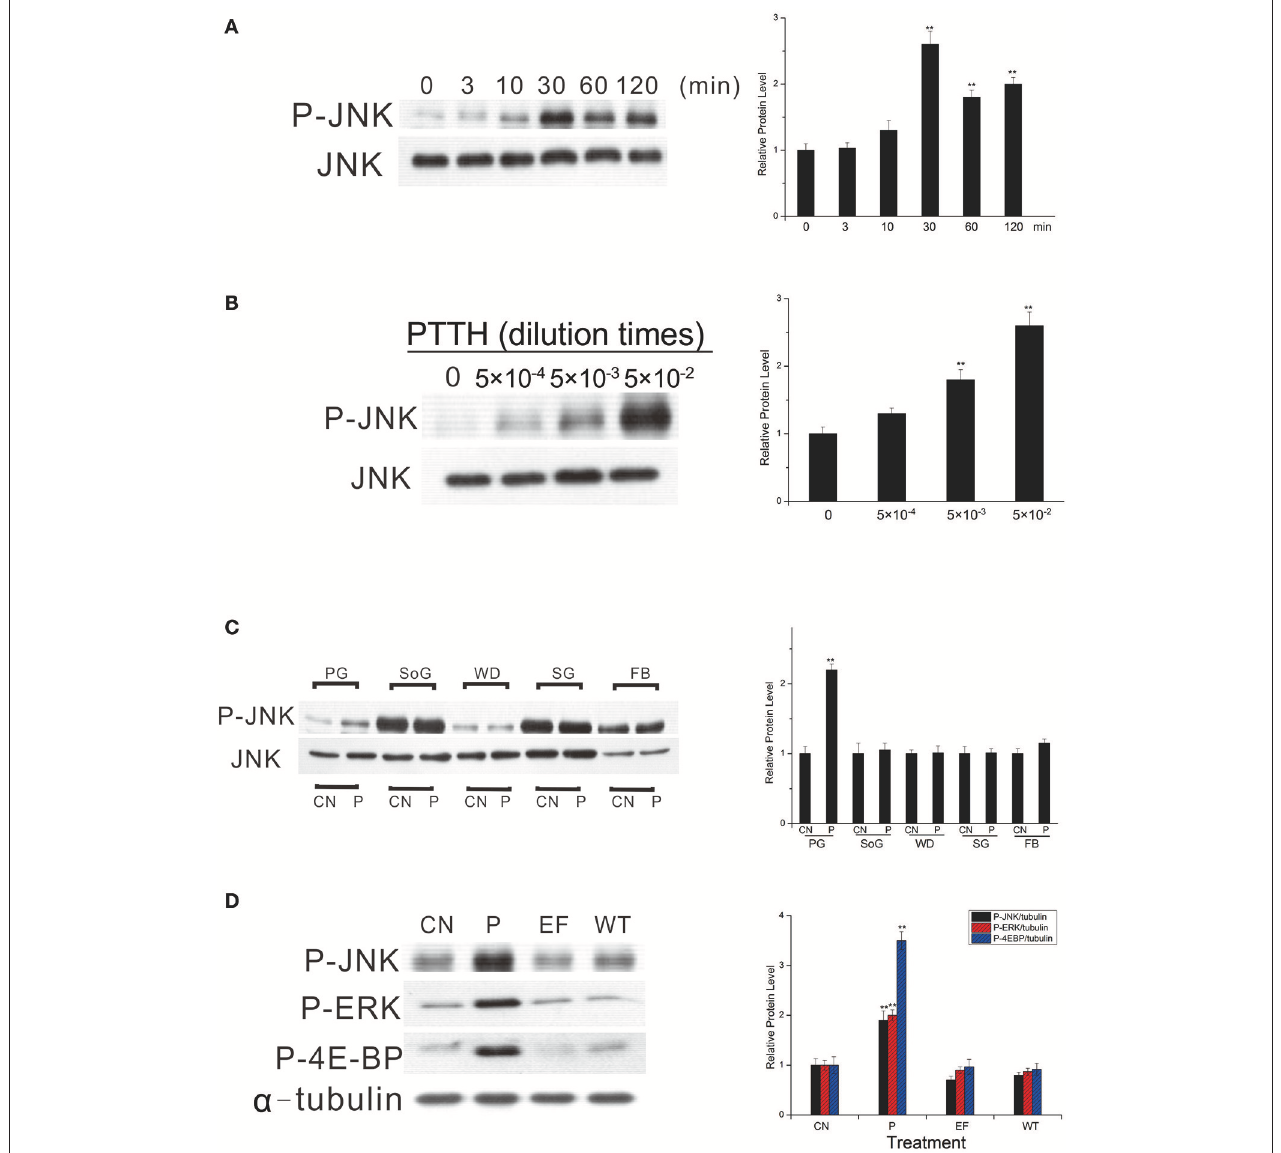
FIGURE 2 | Time- (A) and dose- (B) dependent effects of JNK phosphorylation by the PTTH, tissue specificity of PTTH-stimulated JNK phosphorylation (C) , and the effect of treatment with extracellular fluid from cells only or cells infected with the wild-type (WT) AcMNPV on protein phosphorylation (D) . (A,B) Time- and dose-dependent effects. PGs were either treated with PTTH for the indicated time points (A) , treated with the indicated concentrations of PTTH, or incubated with control medium (0) for 60min (B) . (C) Tissue specificity. PGs, subesophageal ganglia (SoG), wing disks (WD), salivary glands (SG), and fat body (FB) from day 6-last instar larvae were incubated with control medium (CN) or medium containing the PTTH (P) for 60min. (D) Effect of treatment with either control medium (CN), the PTTH (P), extracellular fluid from cells only (EF), or cells infected with WT AcMNPV (WT) on the phosphorylation of JNK, ERK, and 4E-BP. Each lysate was prepared and subjected to an immunoblot analysis with anti-phospho-JNK (P-JNK), anti-phospho-ERK (P-ERK), anti-phospho-4E-BP (P-4E-BP), anti-JNK (JNK), and anti- α -tubulin ( α -tubulin) antibodies. Results shown in the left panels are representative of three independent experiments. Data are expressed as multiples of change over the respective control after being normalized to the level of JNK (for A–C ) or α -tubulin (for D ). Asterisks indicate a significant difference compared to the respective control (by Student’s t -test, ** p <